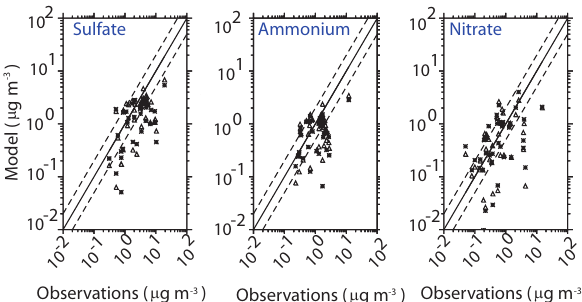
Fig. 13. Simulated concentration of sulfate, ammonium and nitrate aerosol for the year 2001 (star) and 2002 (triangle) compared to AMS data summarised by Zhang et al. (2007).